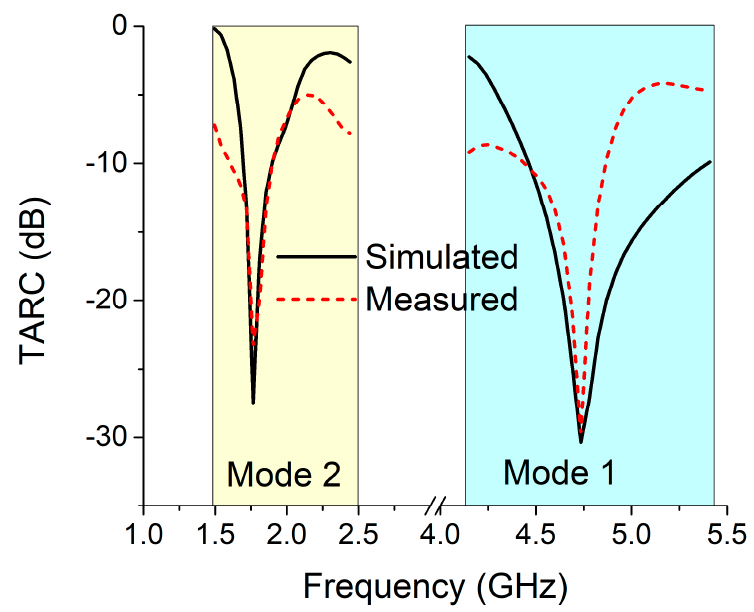
Figure 32. TARC for the MIMO antenna in both modes.